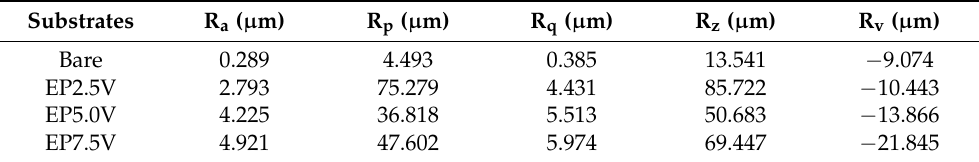
Figure 2. Surface topographic images of untreated and treated 316L SS specimens ( a ) Bare, ( b ) EP2.5V, ( c ) EP5.0V, and ( d ) EP7.5V. Table 2. Surface topographic and roughness parameters for the untreated and treated 316L SS